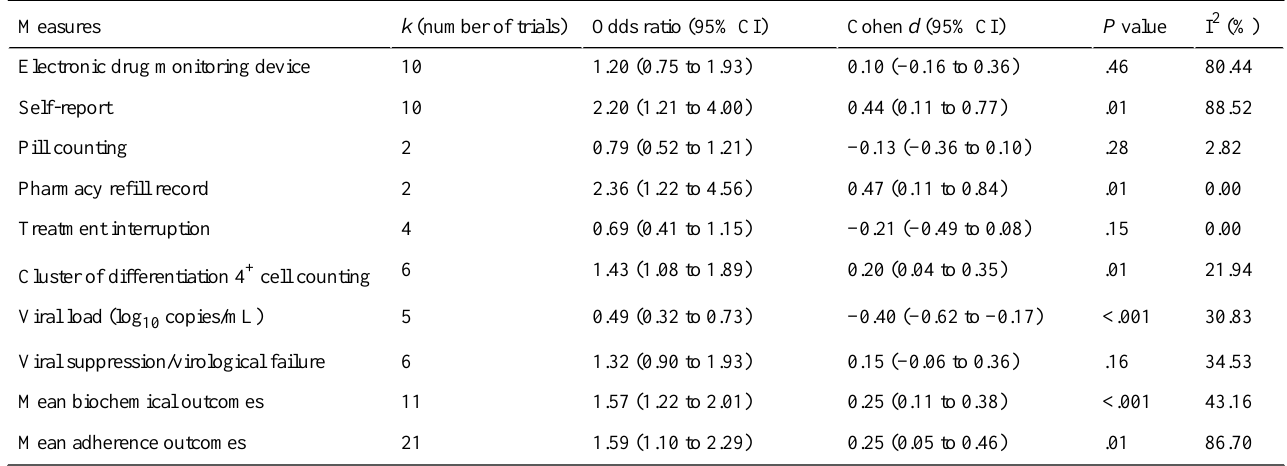
Table 1. The effect of electronic health on antiretroviral therapy adherence outcomes and biochemical outcomes by type of outcome assessing methods.